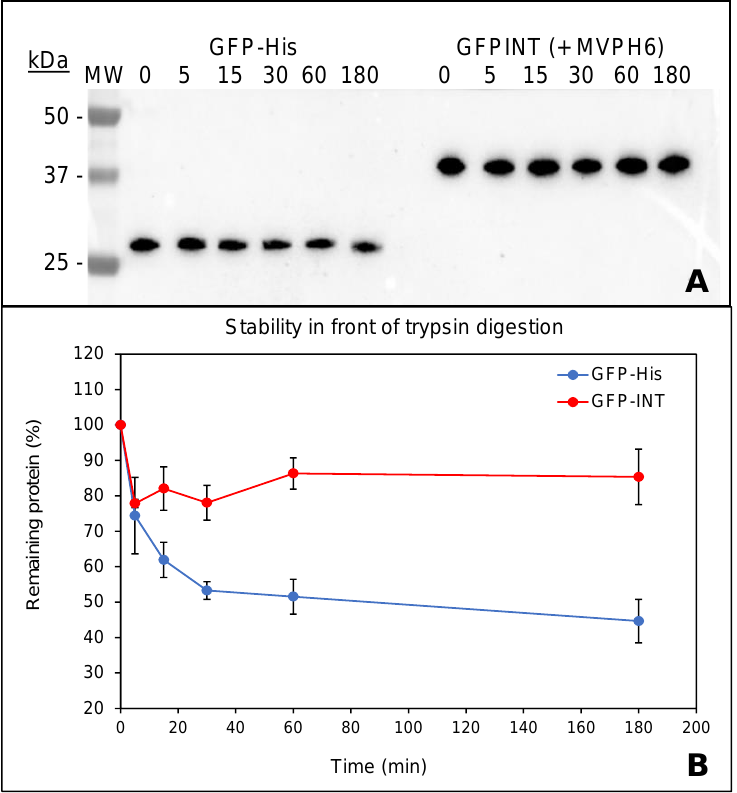
Figure 9. Trypsin digestion of GFP-His and GFP-INT. Samples at the indicated time points (in minutes) were taken and analyzed by SDS-PAGE and Western blot developed with a polyclonal antibody anti-GFP ( A ) detecting both GFP-H6 and GFP-INT. Kinetics of trypsin degradation according to densitometric analysis of Western blots is shown in ( B ). Results shown represent the mean and standard error of the mean (SEM) of two independent samples analyzed by duplicate.